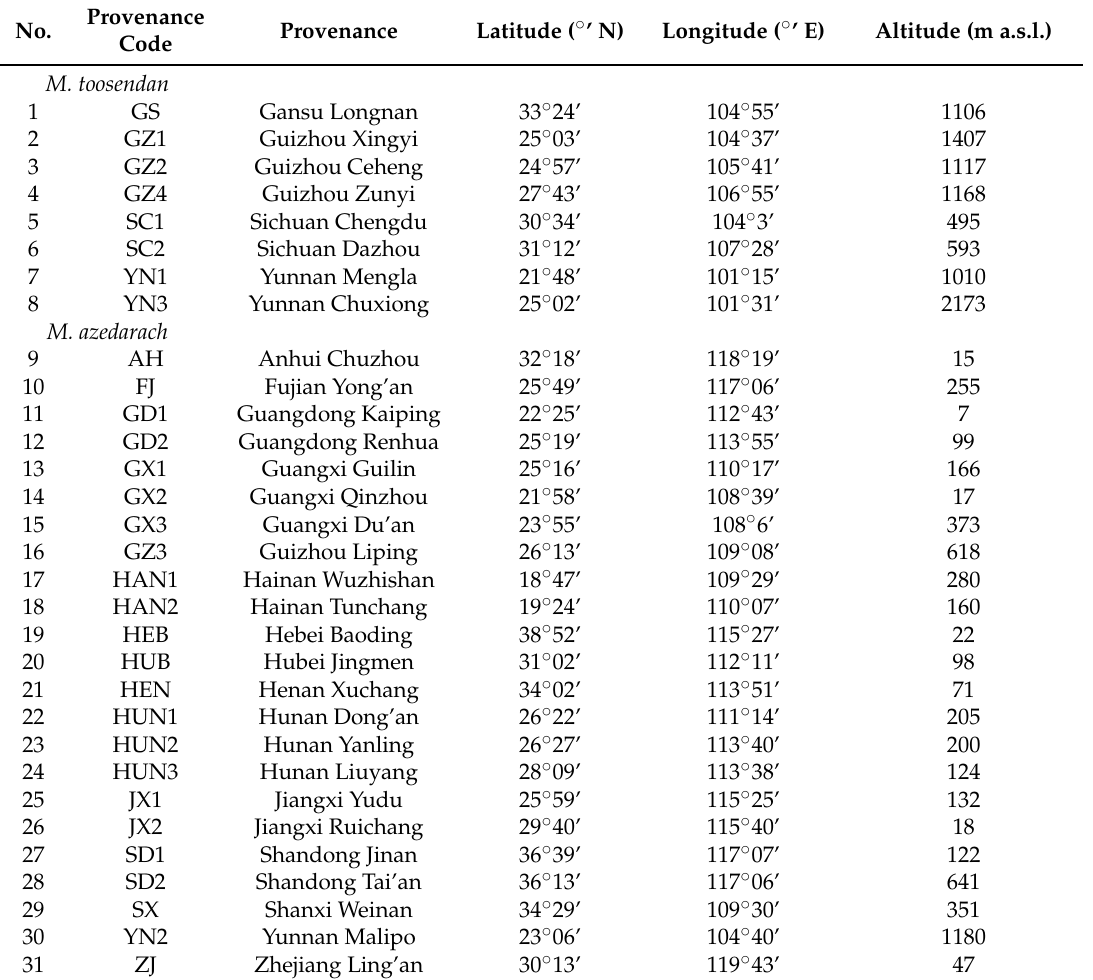
Table 1. Summary of the 31 Melia seed sources sampled in this